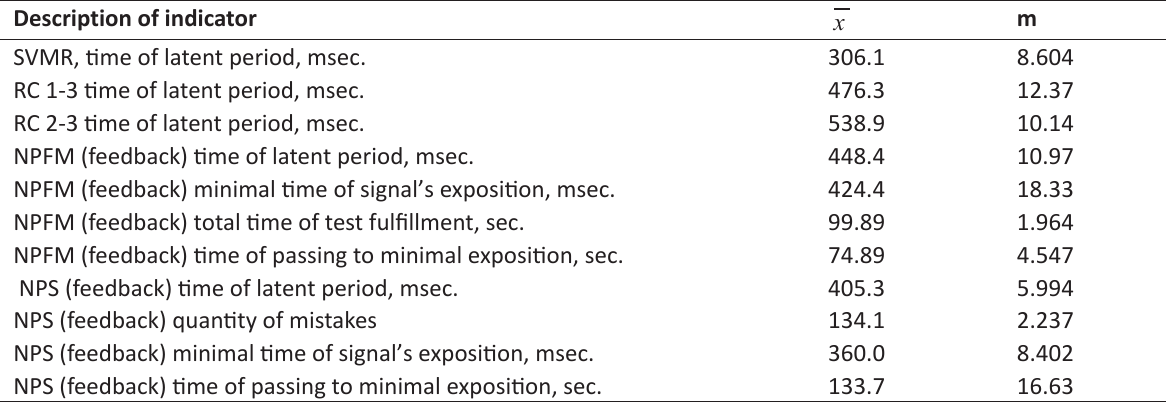
Table 2. Psycho-physiological indicators of qualified wrestlers in special training stage of preparatory period ( х ±m;